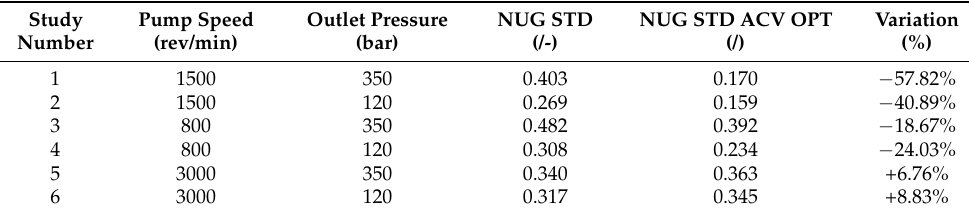
Table 2. Analysis of different working conditions.